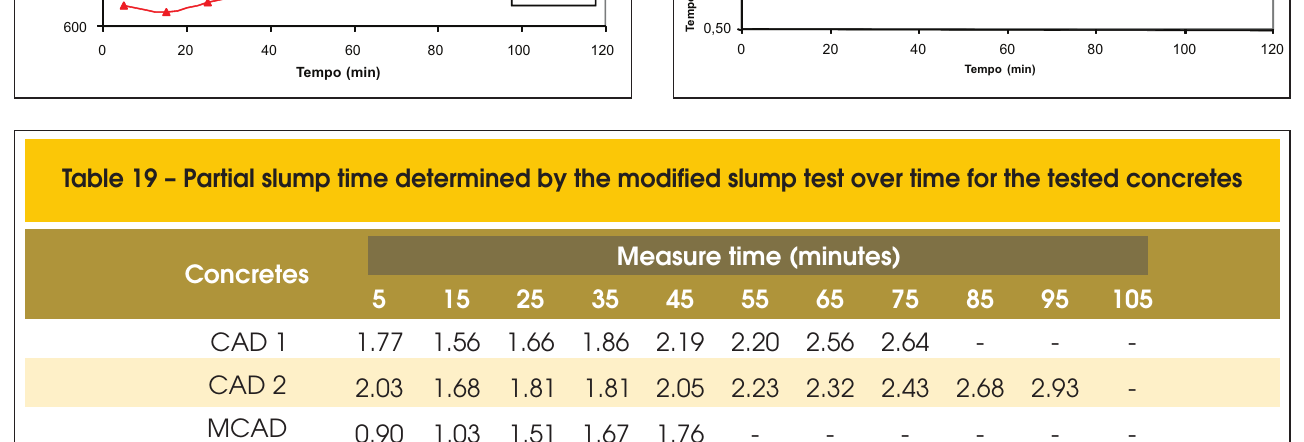
Figure 20 – Yield stress curves over time for the tested concretes